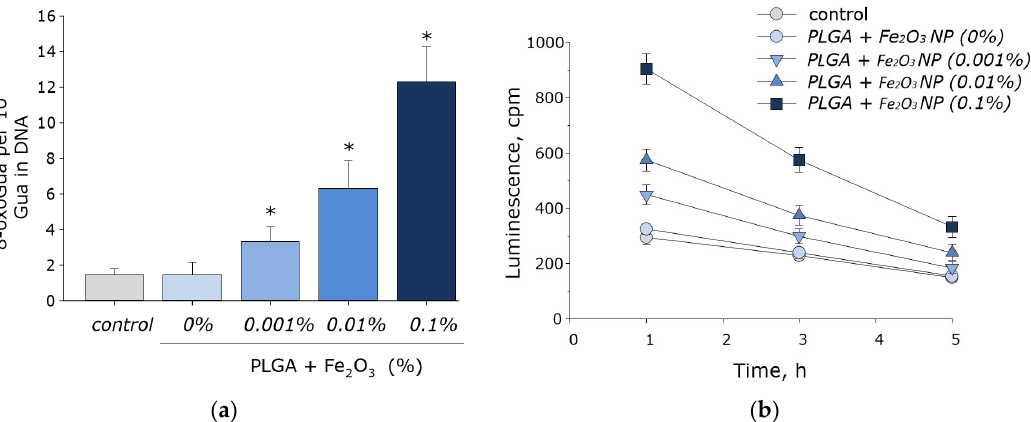
Figure 7. Effect of PGLA-based material with iron oxide nanoparticles on the formation of 8- oxoguanine in DNA ( a ) and the dynamics of the formation of active long-lived forms of proteins ( b ). *—statistically significant differences compared with the control group ( p < 0.05). Data are presented as mean ± standard error of the mean.